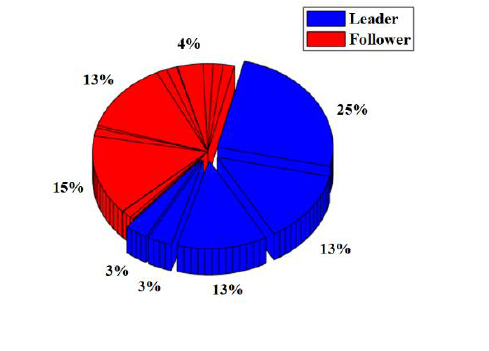
Table 7. The performance of the DDPOS algorithm.